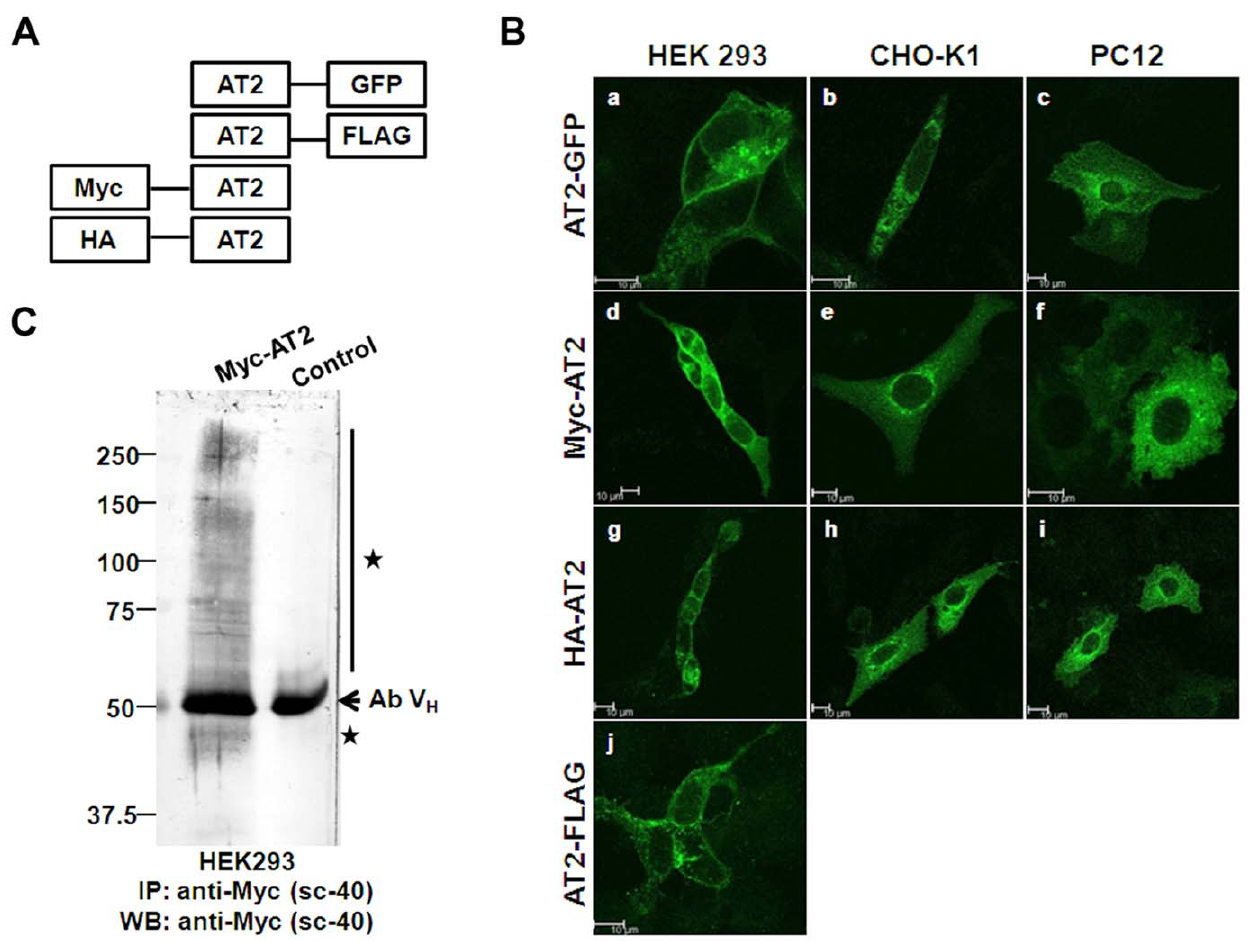
Figure 1. Transient expressions of epitope-tagged AT2 receptors. (A) Schematic illustration of C-terminally or N-terminally tagged AT2 receptor variants. (B) Confocal images of transiently expressed epitope-tagged AT2 receptor variants. Plasmid (1 m g) was transiently transfected into cells (on a 25-mm coverslip). After 24 hr, cells that transfected with AT2-GFP were examined by live cell imaging; cells that transfected with Myc-AT2, HA-AT2 or AT2-FLAG were fixed, permeabilized and probed with an epitope-specific antibody as described in Methods. Following incubation with an FITC-conjugated secondary antibody, fluorescent images of transiently transfected cells were captured using a 63 6 water immersion objective with a Leica SP5 confocal microscope. (C) Pull-down immunoblot protein analysis of HEK293 cells that were transiently transfected with Myc-AT2. The Myc- AT2 expression construct or control empty vector (5 m g) was transiently transfected into HEK293 cells (in a 100-mm dish) as described in Methods. After 48 hr, cells were lysed, immunoprecipitated and probed with an anti-Myc antibody. Specific immunoreactive protein bands are indicated with asterisks. Ab V H : Antibody heavy chain. Data shown is a representative of 2–3 independent experiments with similar results.